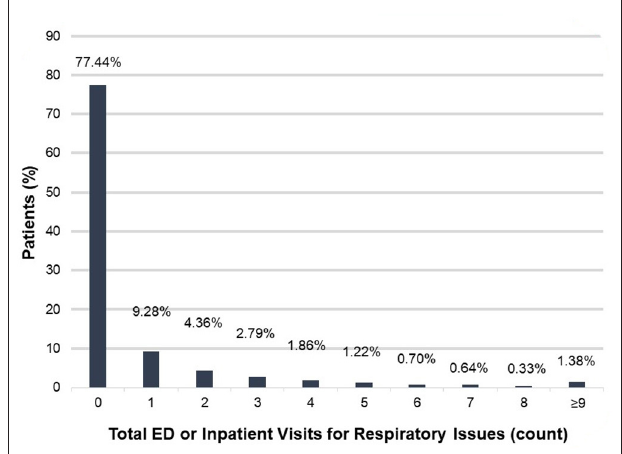
FIGURE 1 | Total ED or inpatient visits for respiratory issues among patients within the rare pulmonary disease cohort over the 1-year study period. ED, emergency